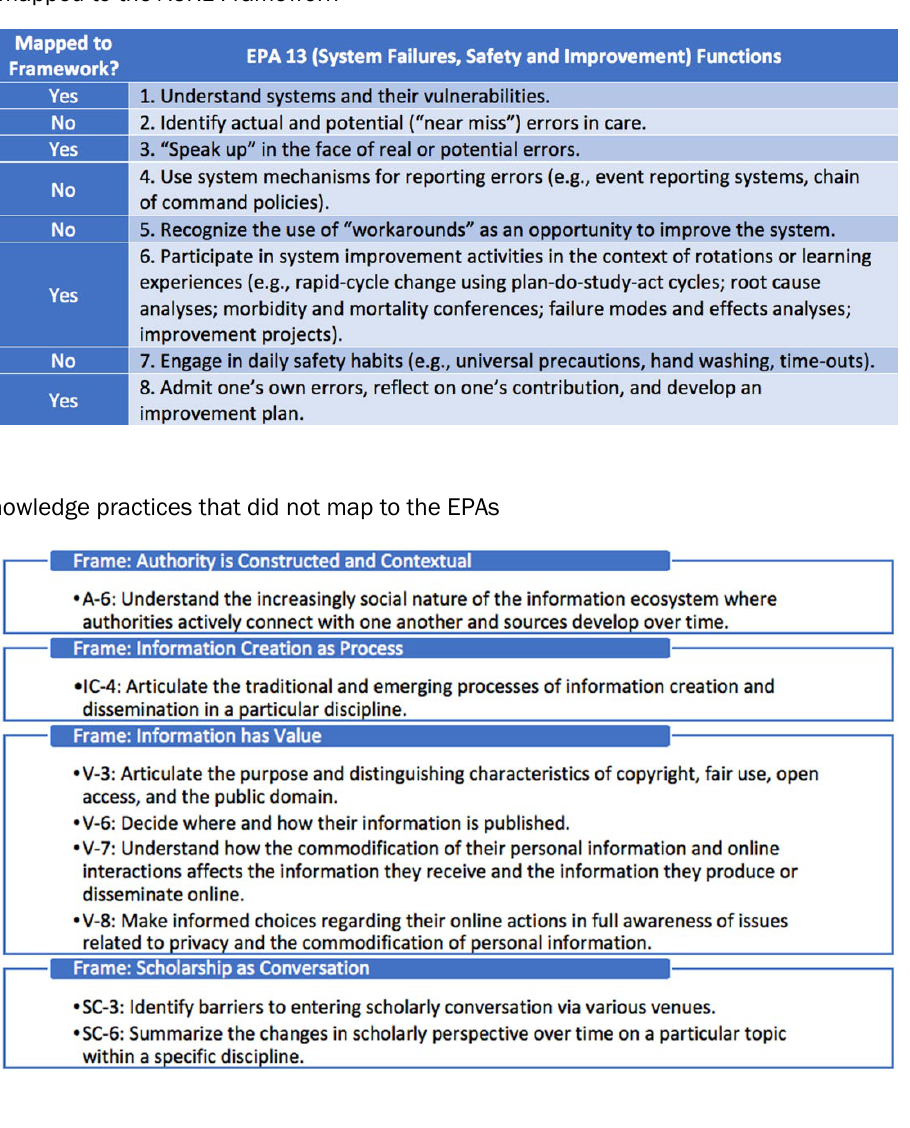
Figure 3 EPA 13 mapped to the ACRL Framework